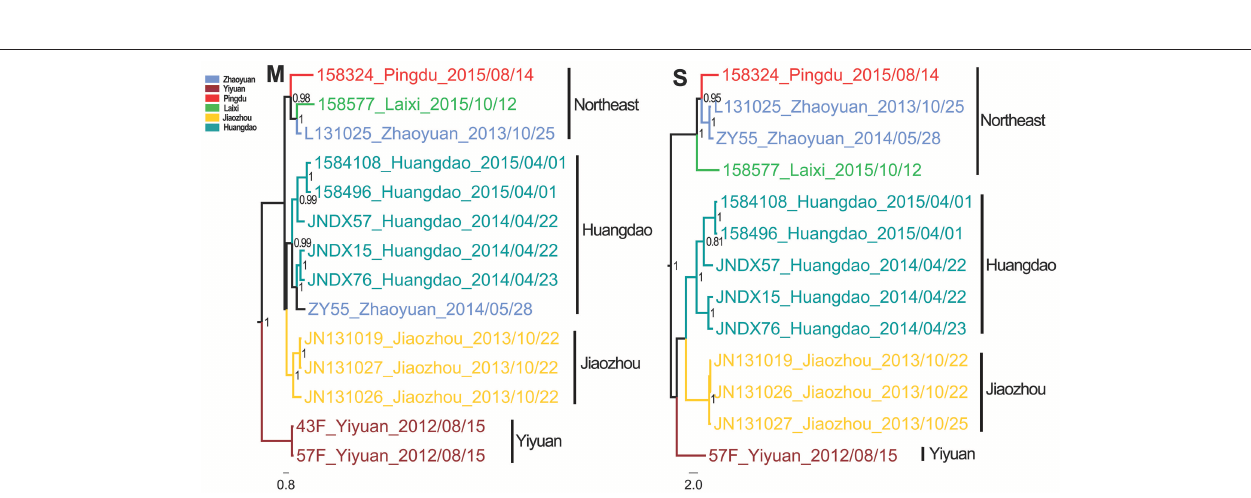
FIGURE 4 | Relative phylogenetic relationships of M and S segment sequences for Hantaan virus defined in MCC trees. Different colors represent the geographic origin of the samples. Numbers at each node are posterior probabilities (PP) based on 1,000,000–5,000,000 trees. Only PP values > 0.6 are shown. The scale bar indicates the nucleotide substitutions per